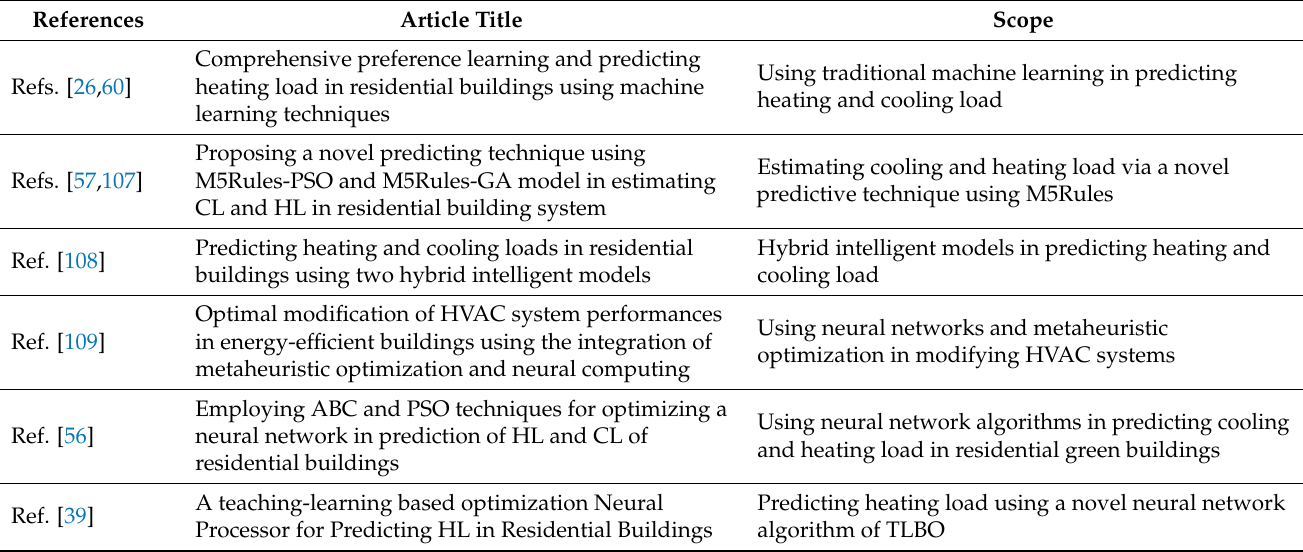
Table 5. Studies focused on research on heating load